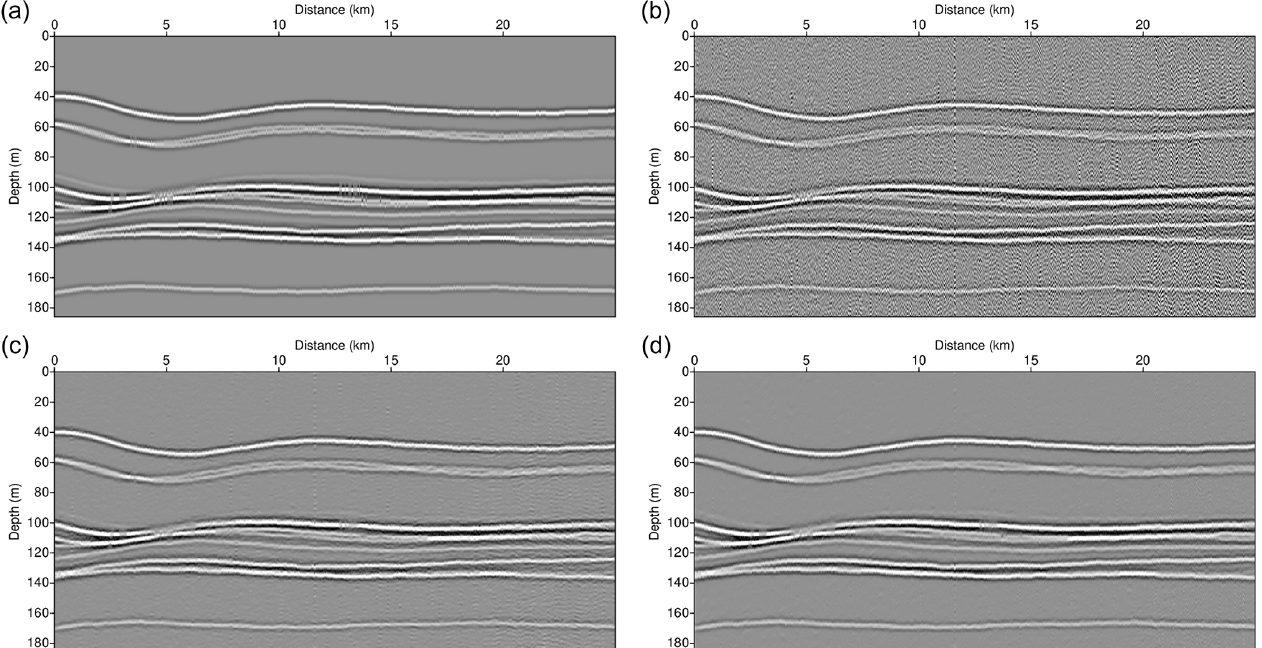
Figure 16. (a) Noise-free and (b) noise-added synthetic water column reflection section and noise-attenuated results using (c) the D1 model and (d) the D2 model.